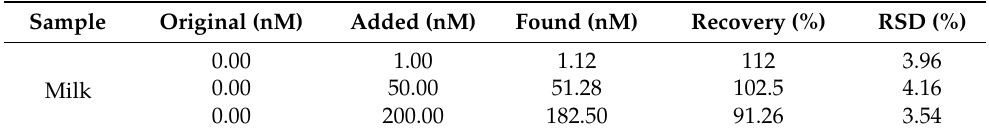
Table 2. Determination of BPA in real samples.